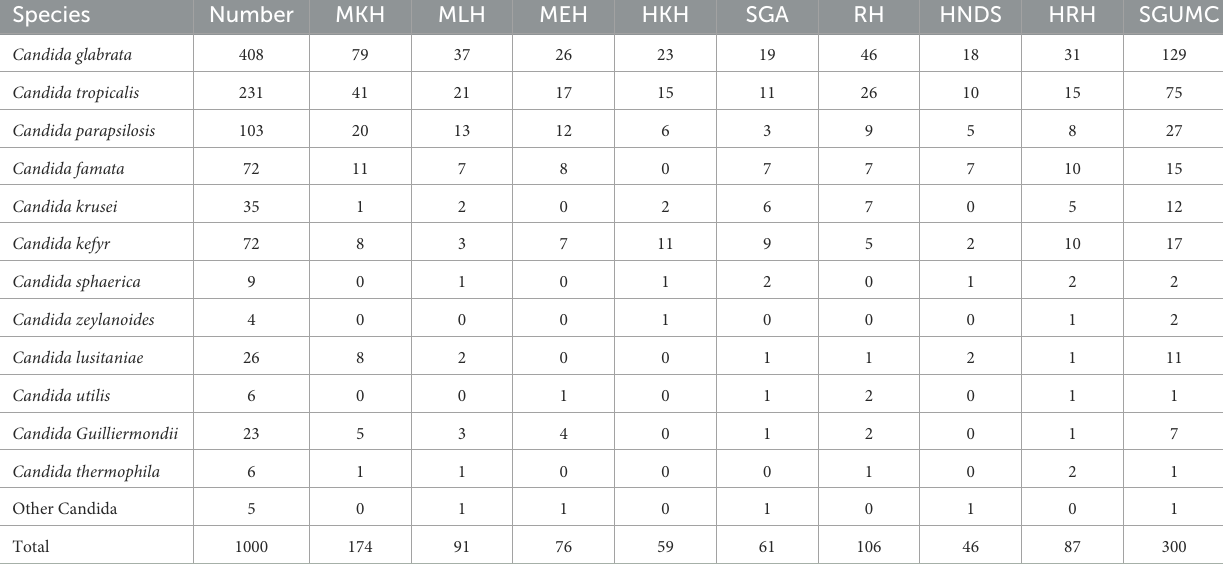
TABLE 1 Distribution of the isolates among the different hospitals. Species Number